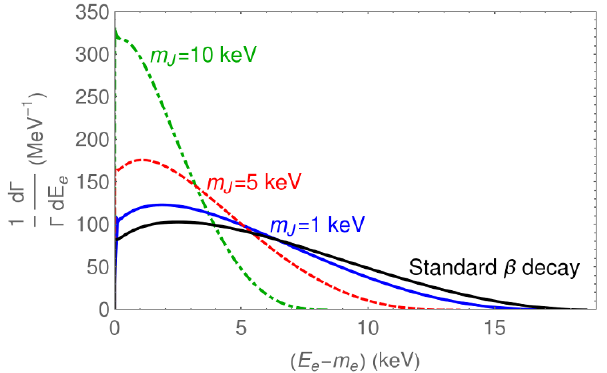
Figure 1 . Normalized electron energy spectrum of the decay 3 H ! 3 He + + e (cid:0) + (cid:22) (cid:23) e + J (with the pseudoscalar J emitted from the neutrino) and the standard (cid:12) -decay spectrum. The coupling g (cid:23)J has been set to 1 , the spectrum scales with g 2 (cid:23)J